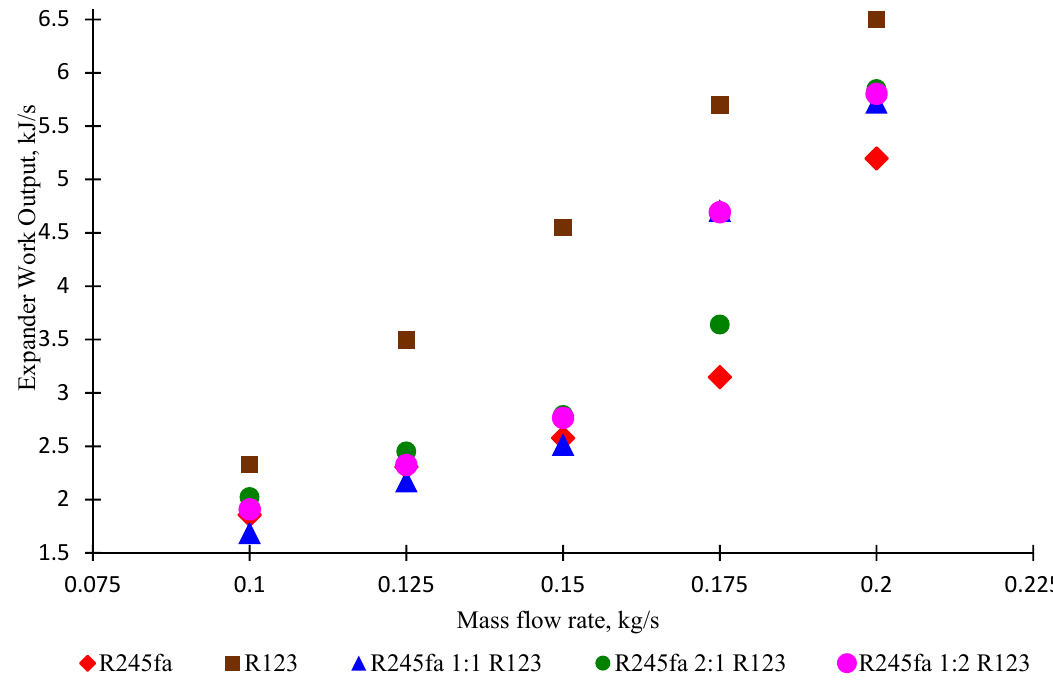
Figure 18. Expander work output as a function mass flow rate for R245fa, R123, and mixed working fluids with heat source at 120 ° C.